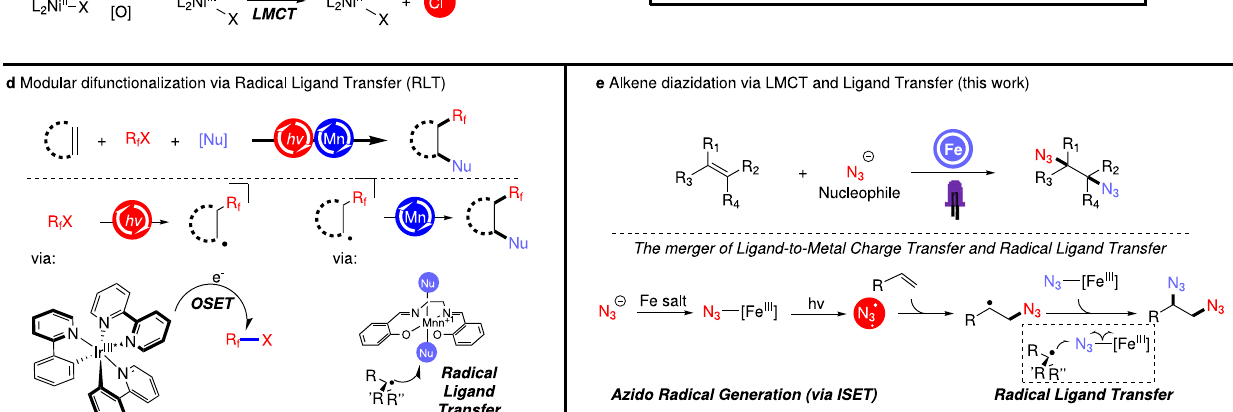
MetalChargeTransfer(LMCT)enablesradicalgeneration. d Radicalligandtransfer allowsforfaciledeliveryoforthogonalnucleophiles. e Thesynergisticcooperation of LMCT and RLT in alkene